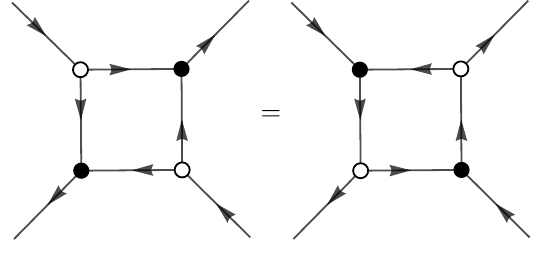
Figure 3 . Square move equivalence relation SYM.